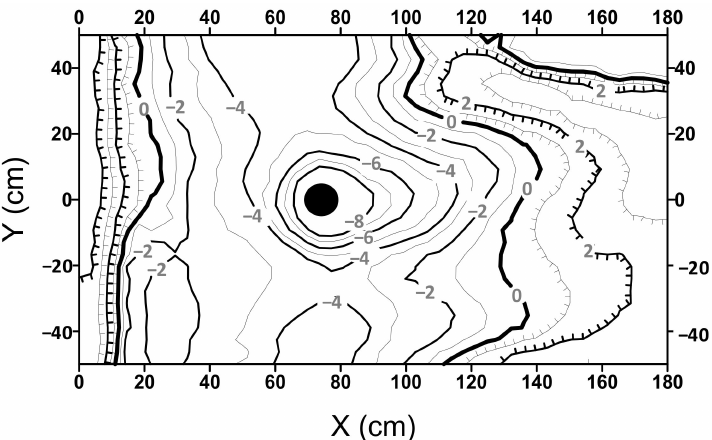
Figure 8. Topography of Case 0 (without CKAW) after the pier scour reached an equilibrium state (the erosion and deposition contour is 1